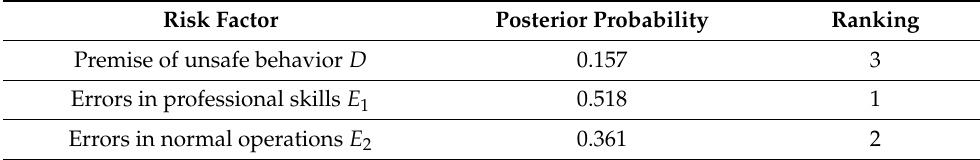
Table 9. Posterior probability of reasoning on node E.